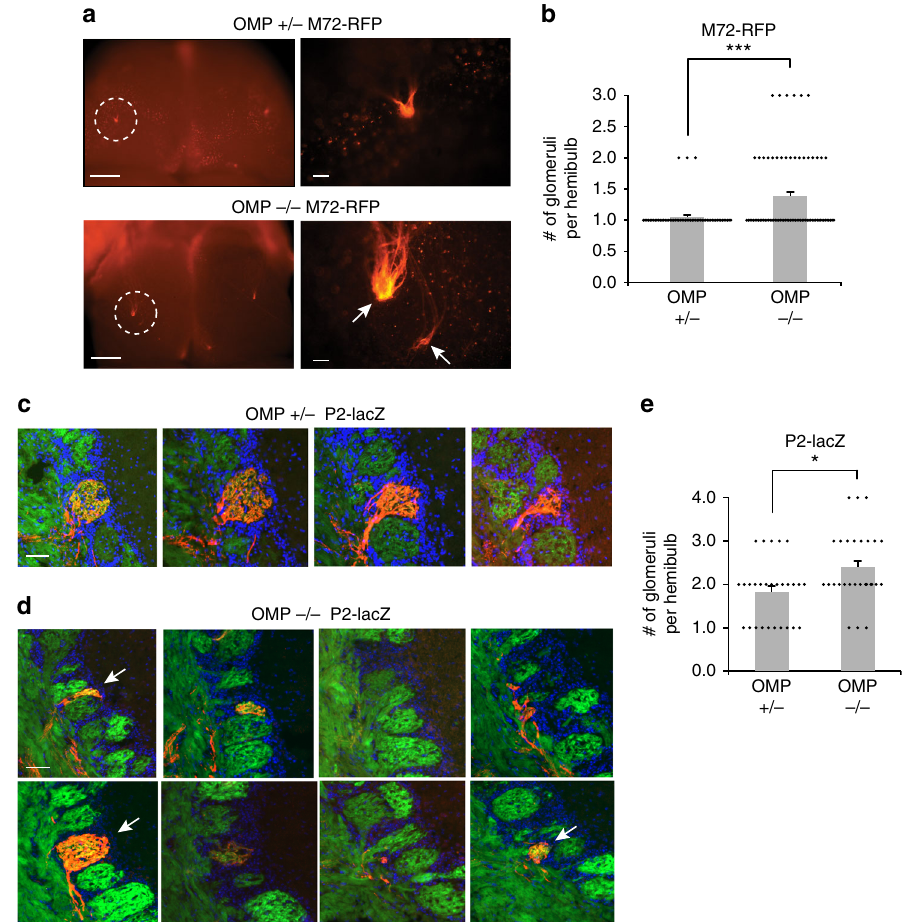
Fig. 5 Duplicate glomeruli in the OMP – / – mice. a (Left) Whole mount of the OB dorsal surface in a M72-RFP OMP + / – (Top) and OMP – / – (Bottom) mouse with a the M72 glomerulus fl uorescently labeled. Scale bar, 500 μ m. (Right) Zoom-in of circled region. Note the duplicated glomeruli in the OMP – / – mouse (arrows). Scale bar, 100 μ m. b Quanti fi cation of duplicate glomeruli in M72-RFP mice for OMP + / – and OMP – / – mice. Shown are 1.05 ± 0.03 glomeruli per hemi fi eld (mean ± SEM, n = 56 hemibulbs) in OMP + / – mice and 1.36 ± 0.07 glomeruli per hemi fi eld (mean ± SEM, n = 76 hemibulbs) in OMP – / – mice. c Serial coronal sections through individual glomeruli in one hemibulb of a P2-lacZ OMP + / – mouse. P2-positive OSN axons are labeled with β -Gal (red), OSN axons with SpH (green), and nuclei of juxtaglomerular cells surrounding glomeruli by DAPI (blue). Scale bar, 50 μ m. d Serial coronal sections of a multiple glomeruli in one hemibulb of a P2-lacZ OMP – / – mouse. Arrows indicate distinct glomeruli and fl uorescent labels as in ( c ). Scale bar, 50 μ m. e Quanti fi cation of duplicate glomeruli in P2-lacZ mice for OMP + / – and OMP – / – mice. Shown are 1.82 ± 0.14 glomeruli per hemi fi eld (mean± SEM, n = 28 hemibulbs) in OMP + / – mice and 2.39 ± 0.16 glomeruli per hemi fi eld (mean ± SEM, n = 28 hemibulbs) in OMP – / – mice. * P < 0.05, *** p < 0.001,